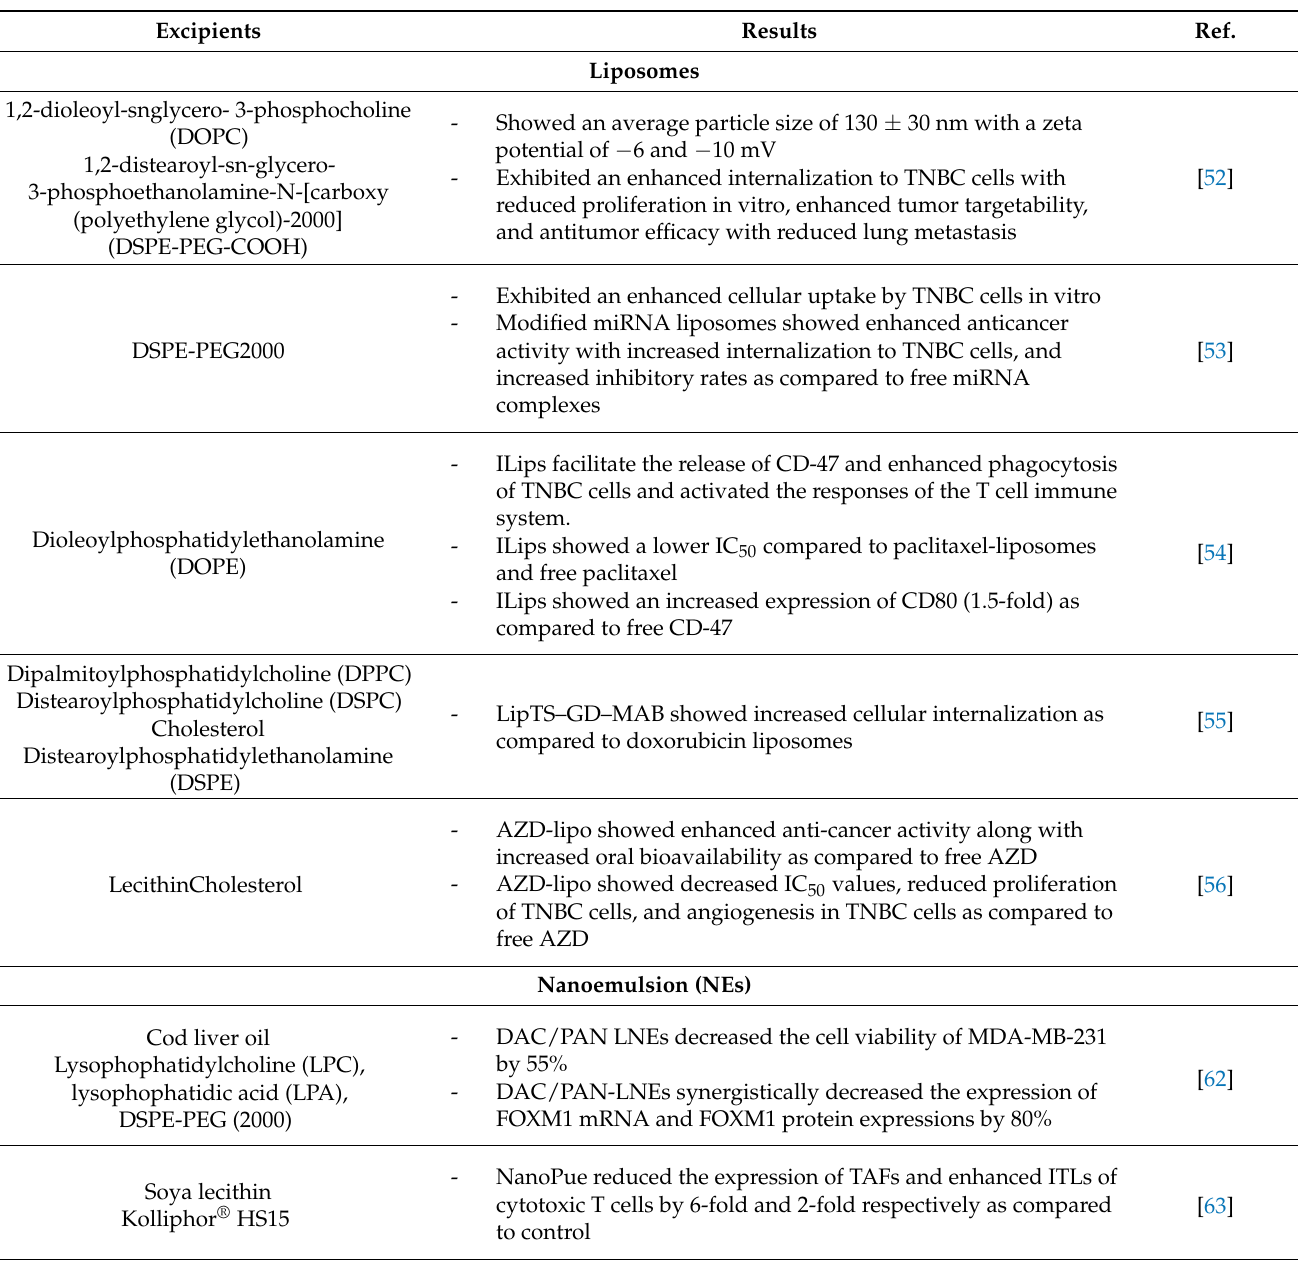
Table 3. Summary of different LNPs employed for the treatment of